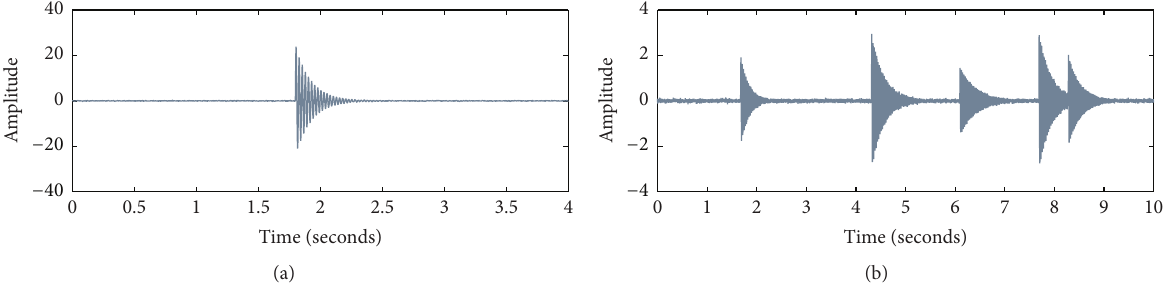
Figure 5: (a) Simulated time series containing single seismic event generated according to (16) with parameters 𝐴 = 20 , 𝜆 = 4 , 𝜔 = 80𝜋 , and 𝜃 = 0 , with signal-to-noise ratio equal to 25. (b) Simulated time series consisting of several seismic events where each seismic event is driven by different set of parameters used in (16).